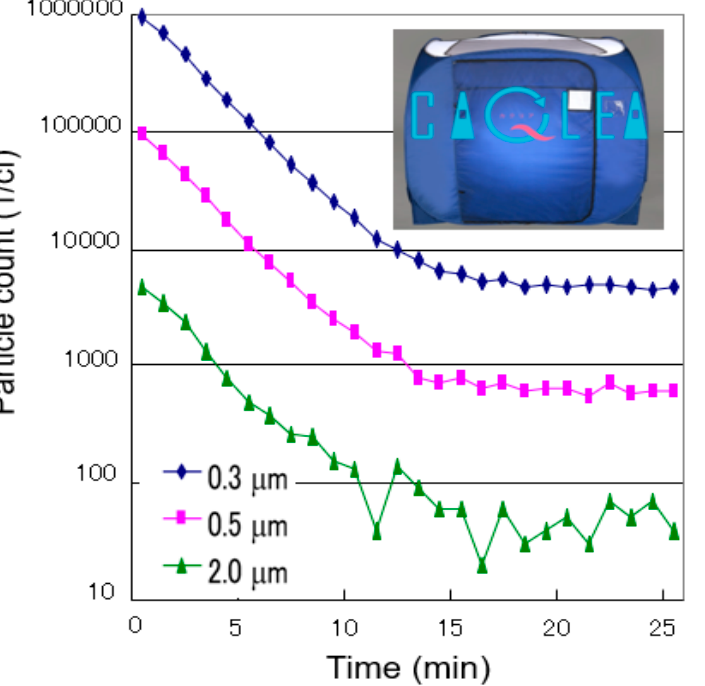
Figure 2. Performance of our new CUSP system, CAQLEA. Shown is the time-dependence of the particle numbers, in CAQLEA, per 1 cubic foot (cf) with diameters of 0.3, 0.5, and 2.0 m.